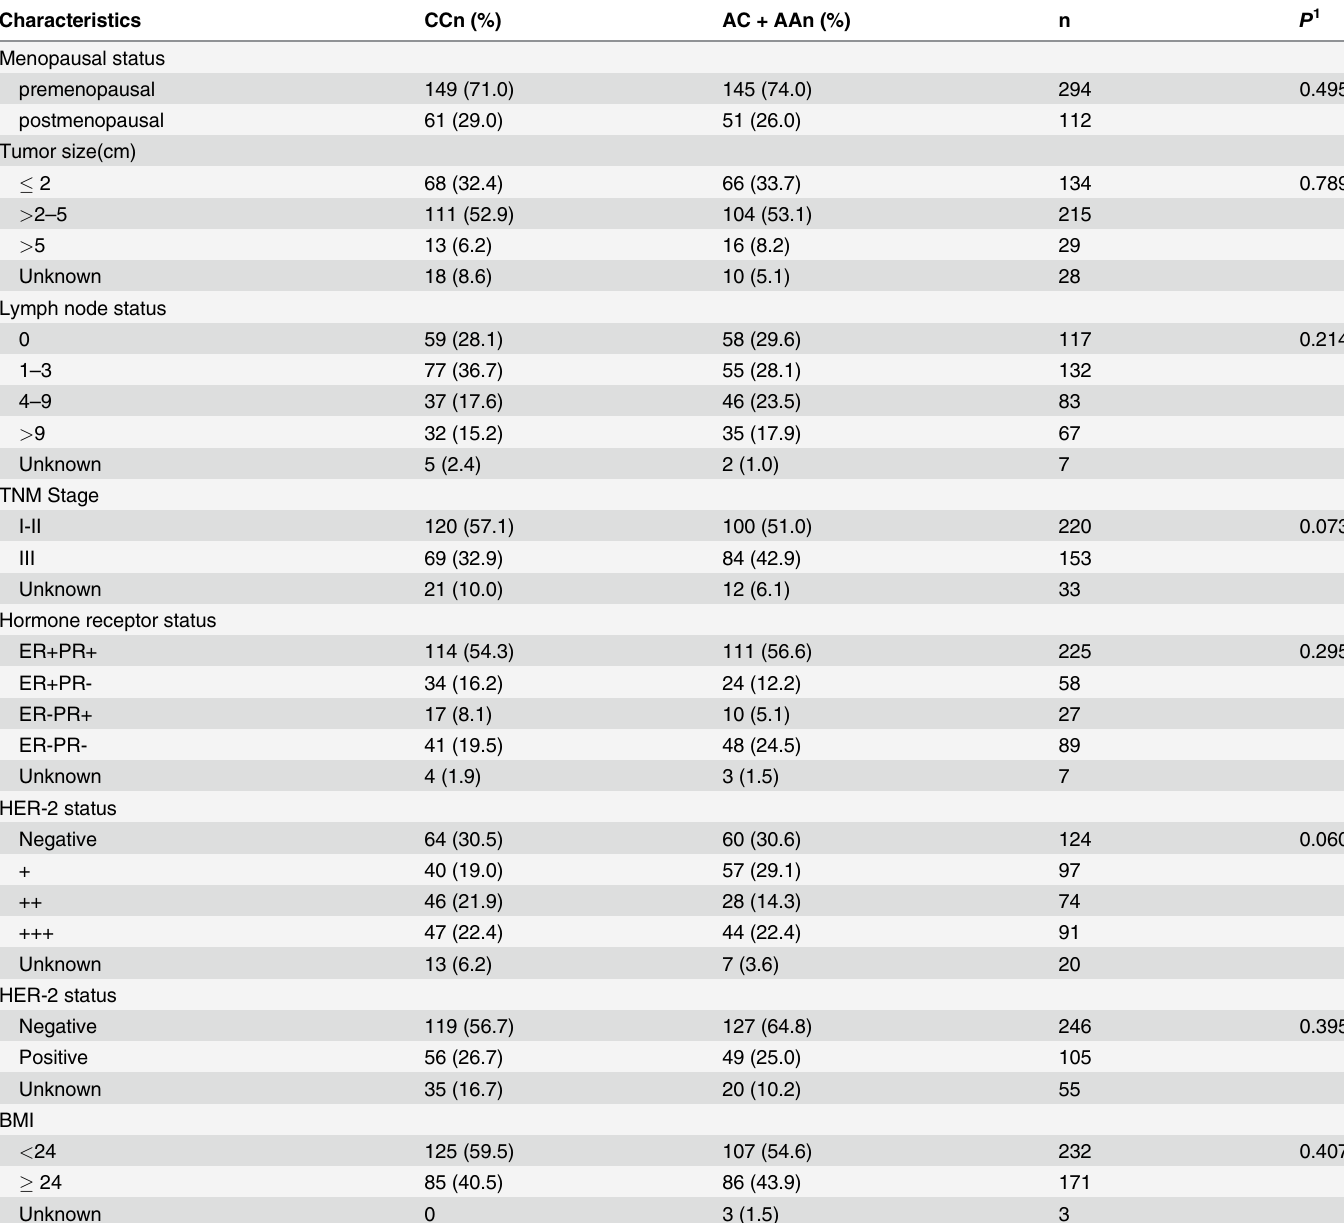
Table 2. Correlation of CYP19 variants (CC vs AC + AA) to clinical characteristics.